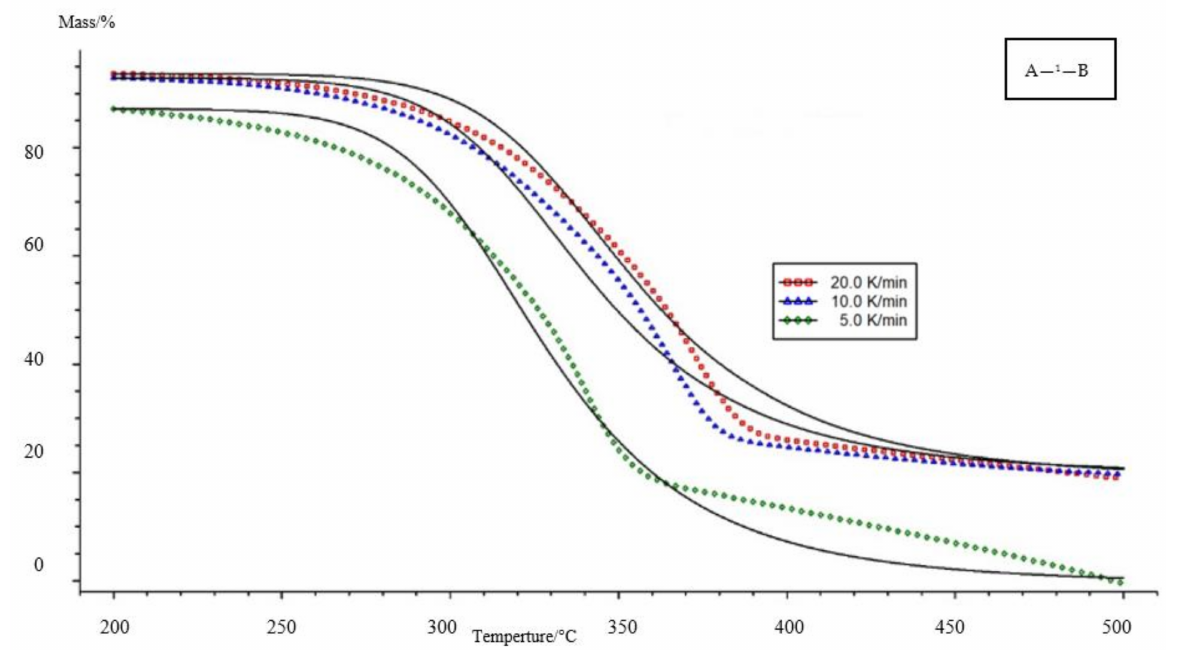
Figure 15. Fitting the calculated kinetic model for pine wood to the experimental data.